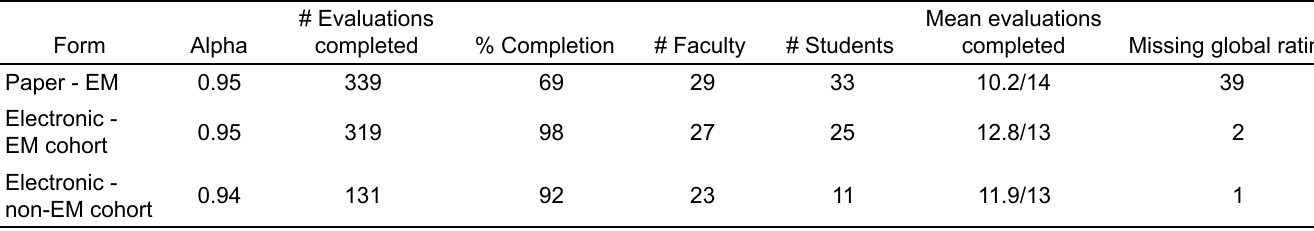
Table 2. Descriptive statistics of evaluation